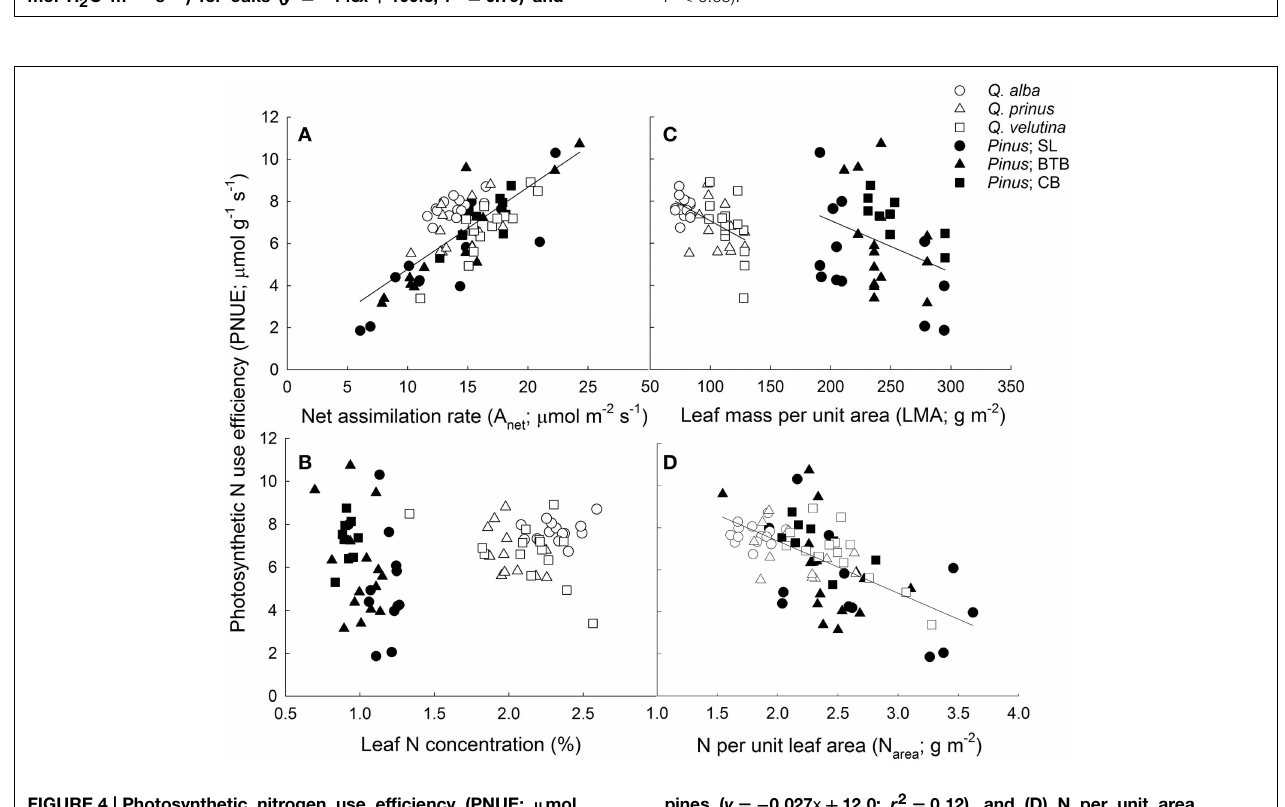
pines ( y = − 224 x + 131 . 6 ; r 2 = 0 .54), and (C) leaf mass per unit area (LMA; g m − 2 ) for oaks and pines. Points represent average across A / C i and light response curves for each individual during each measurement period. Solid lines represent significant relationships (slope P < 0 . 05 ).